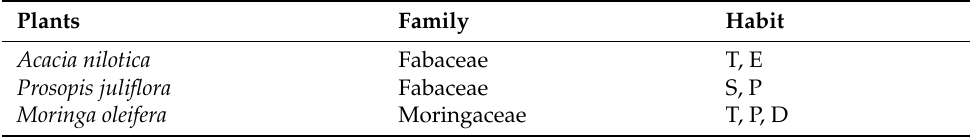
Table 6. Resin-producing plants visited by Megachile cephalotes .